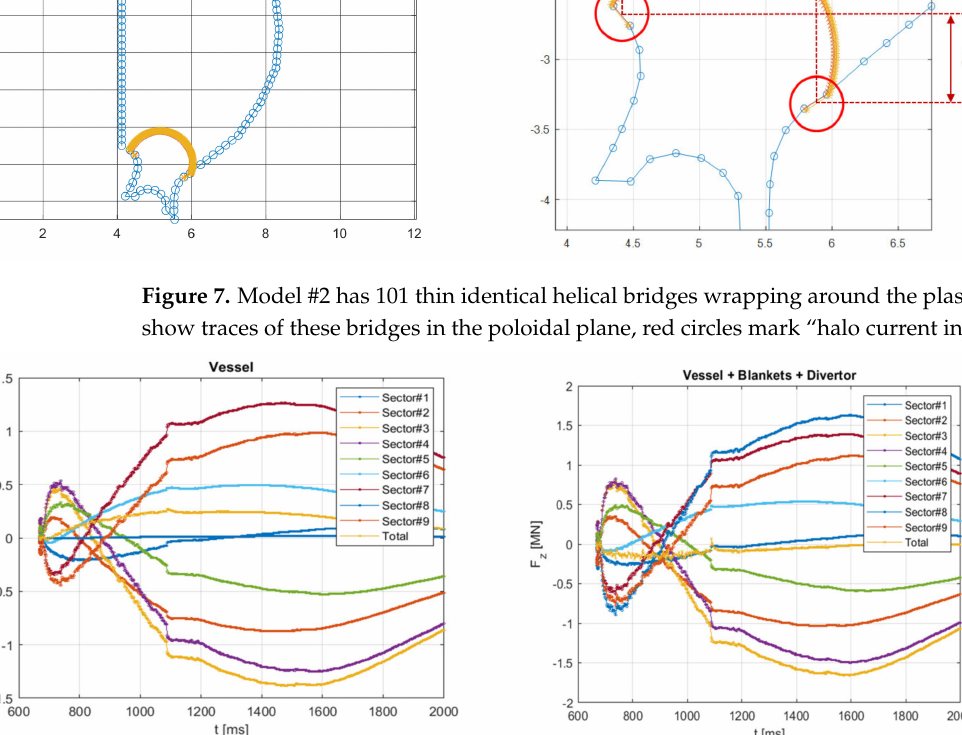
Figure 8. Vertical forces F z created in each of 9 VV sectors themselves and total for sectors composed by the vessel, blanket, and divertor, due to interaction of the anti-symmetric halo current component with external toroidal magnetic field, for Model